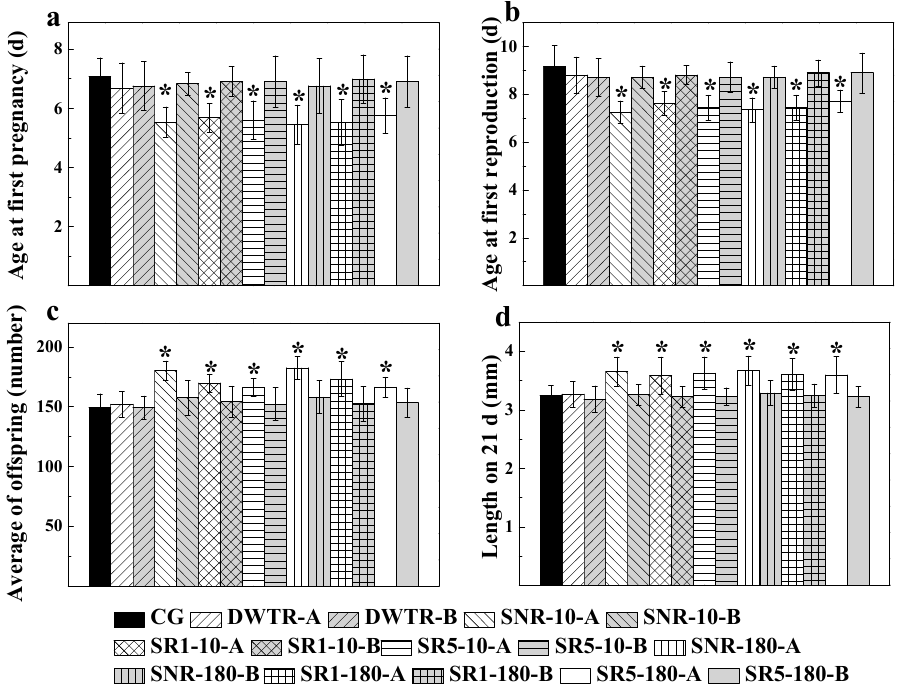
Figure 2. Age at first pregnancy ( a ), age at first reproduction ( b ), average number of offspring ( c ), and length on 21 d ( d ) of D. magna . A and B represent the concentrations of treatment culture at 5000 and 500 mg L − 1 , respectively; CG represents control group; * above the columns represents statistical significance ( p < 0.05) between results of the control and the treatments.